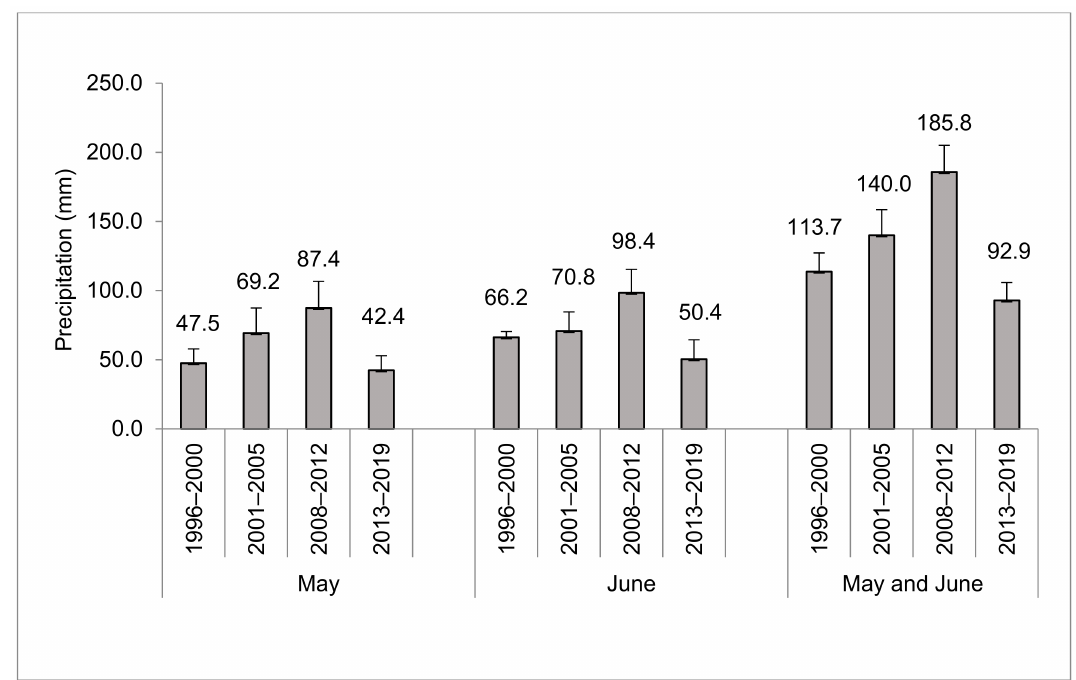
Figure 2. Estimation of precipitation differences by grouping them into subperiods (1996–2000, 2001–2005, 2008–2012,